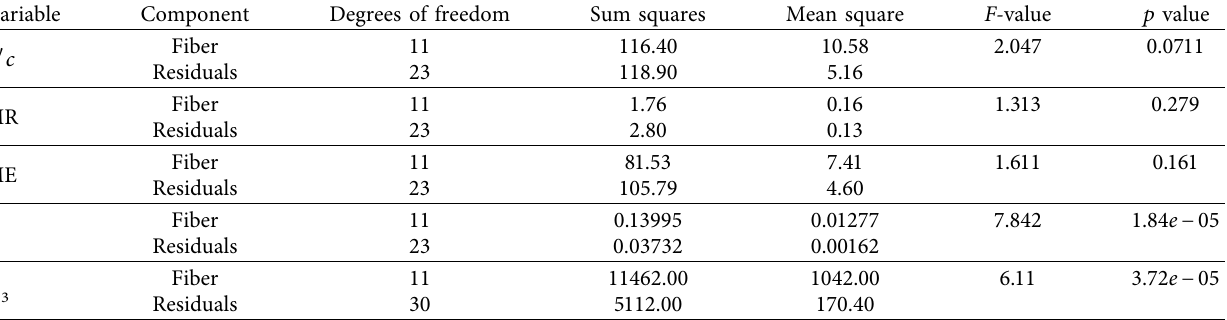
Table 7: Analysis of variance.